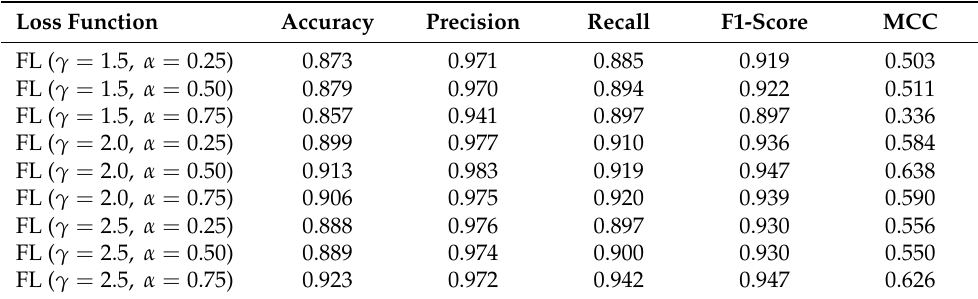
Table 10. Classification results with RGB dataset for varying cost functions and respective parameter sets. (patch size parameter S = 100, 3D convolutions, see Figure A2 for network topology). Loss Function Accuracy Precision Recall F1-Score MCC FL ( γ = 1.5, α = 0.25) 0.852 0.964 FL ( γ = 1.5, α = 0.50)